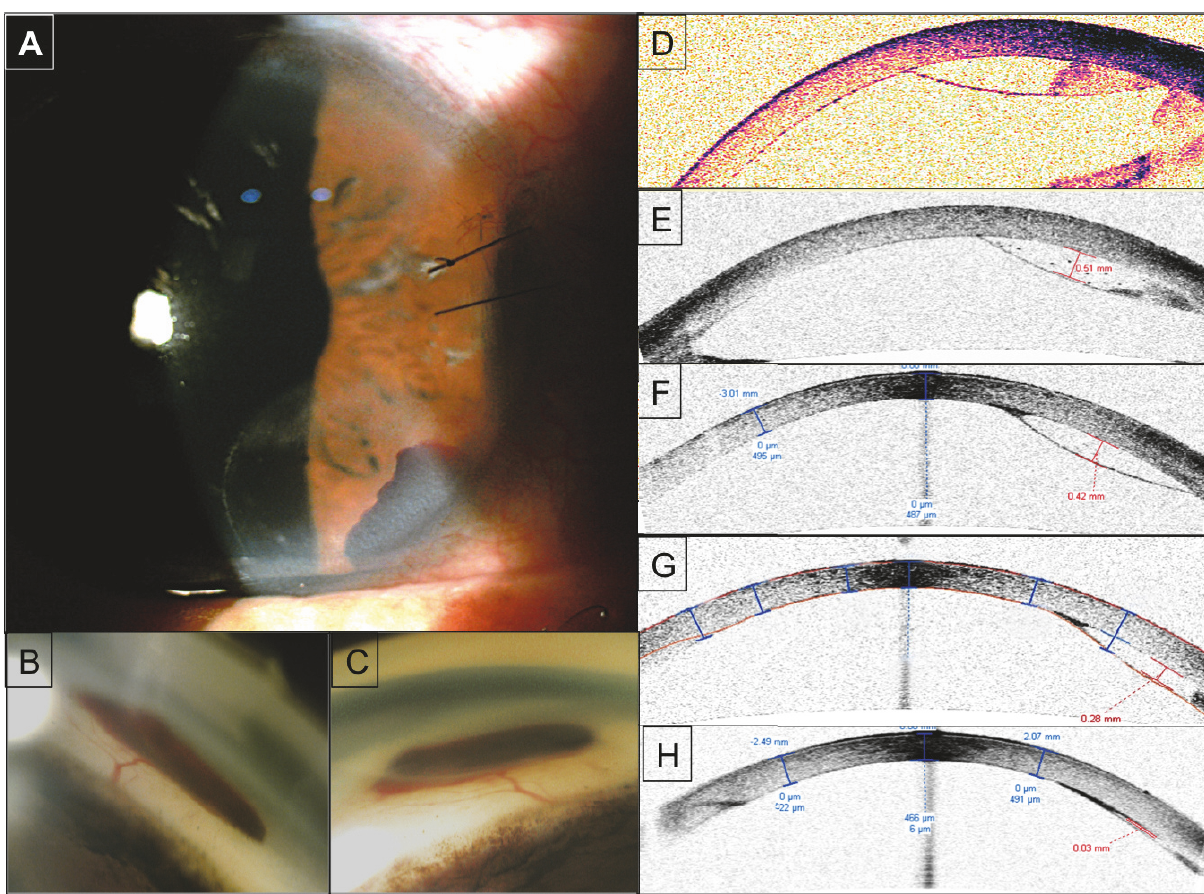
Figure 1: (A) First day after the surgery. Picture of the slit lamp showing a Descemet membrane detachment with partial intrastromal hemorrhage. (B) Gonioscopy evidencing Descemet detachment with intrastromal hemorrhage, 1st day after the surgery. (C) Gonioscopy evidencing Descemet detachment with intrastromal hemorrhage 1st month after the surgery with a reduction of the extent of the injury. (D) OCT of anterior segment (Visante, Model 1000, Carl Zeiss Meditec , Dublin CA, USA), showing intrastromal hemorrhage. (E) OCT Anterior Section, second week after the surgery (4 January 2018). (F) OCT Anterior Section, sixth week after the surgery (2 February 2018). (G) OCT Anterior Section, tenth week after the surgery (1 March 2018). (H) OCT Anterior Section, twelfth week after the surgery (19 March